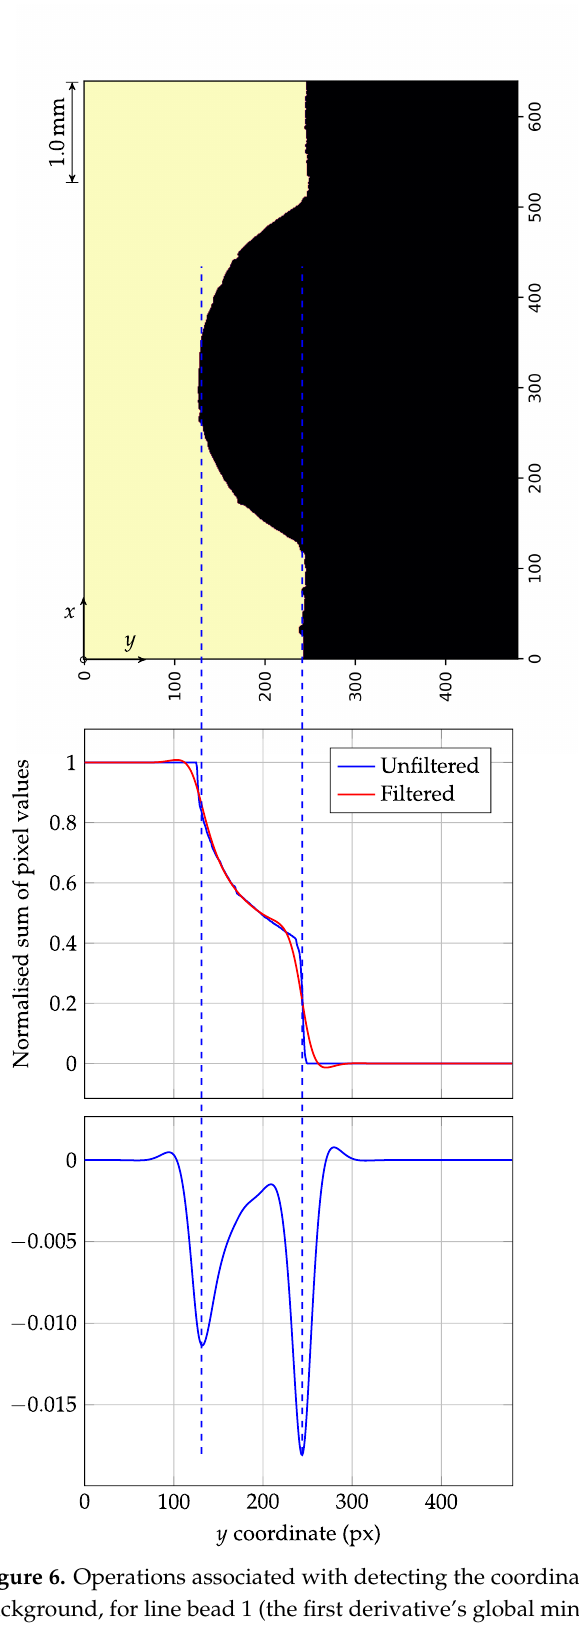
Figure 6. Operations associated with detecting the coordinate of the substrate’s interface with the background, for line bead 1 (the first derivative’s global minimum is one potential indicator of the substrate’s starting